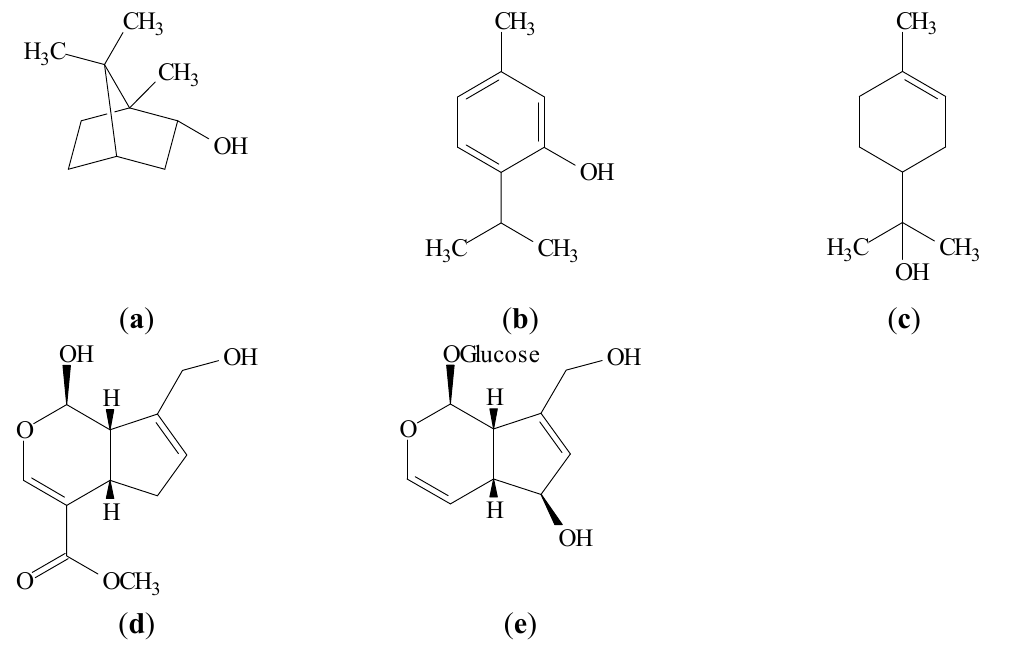
Figure 2. Structural formulae of ( a ) ( − )-borneol, ( b ) thymol, ( c ) α -terpineol, ( d ) genipin and ( e )